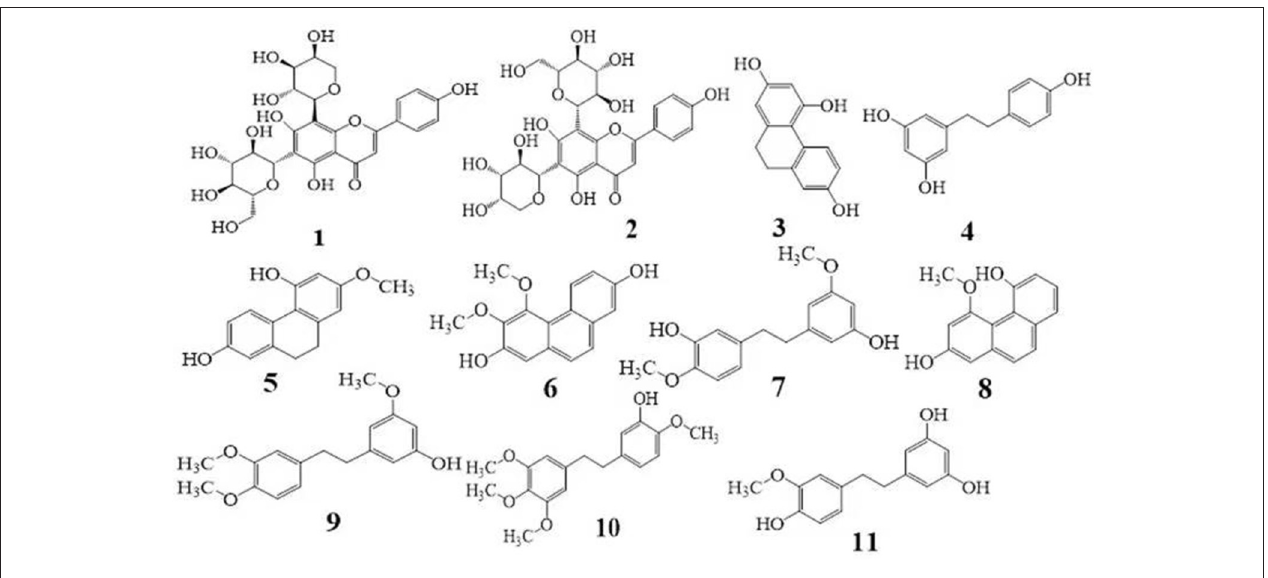
FIGURE 1 | Chemical structures of the 11 phenolic compounds. (1) schaftoside; (2) isoschaftoside; (3) 2,4,7-trihydroxy-9,10-dihydrophenanthrene; (4) dihydroresveratrol; (5) coelonin; (6) nudol; (7) gigantol; (8) 4-methoxy-2,5-phenanthrenediol; (9) 3-hydroxy-3,4,5-trimethoxybibenzy; (10) erianin; and (11)